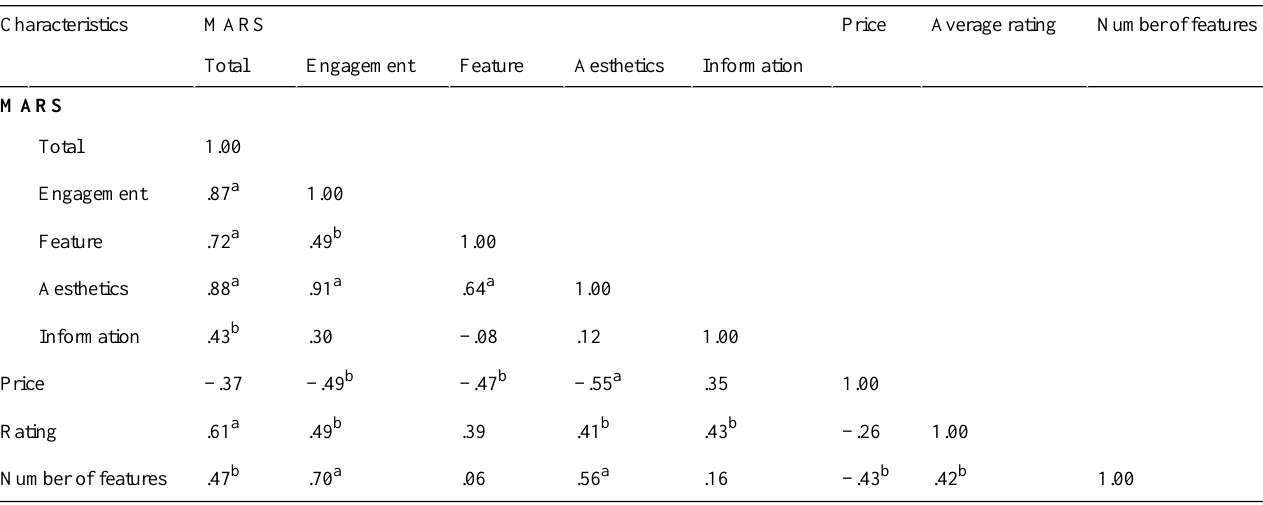
Table 2. Correlations among total Mobile App Rating Scale (MARS) score, four MARS dimension scores, price, rating, and number of features.